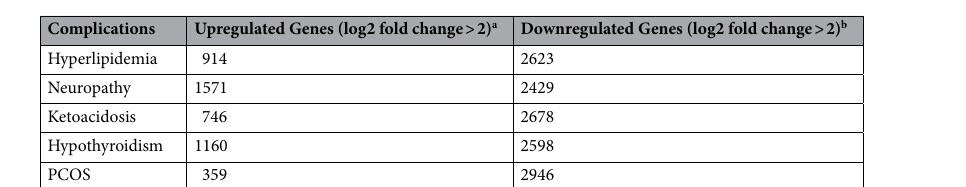
Table 3. Total number of upregulated and downregulated genes per complication group with log2 fold change greater than 2. a Indicates the total number of differentially expressed genes (Upregulated) and b indicates total number of differentially expressed genes (Downregulated) across five diabetes complications (Hyperlipidemia, Neuropathy, Ketoacidosis, Hypothyroidism and PCOS). PCOS Polycystic Ovarian